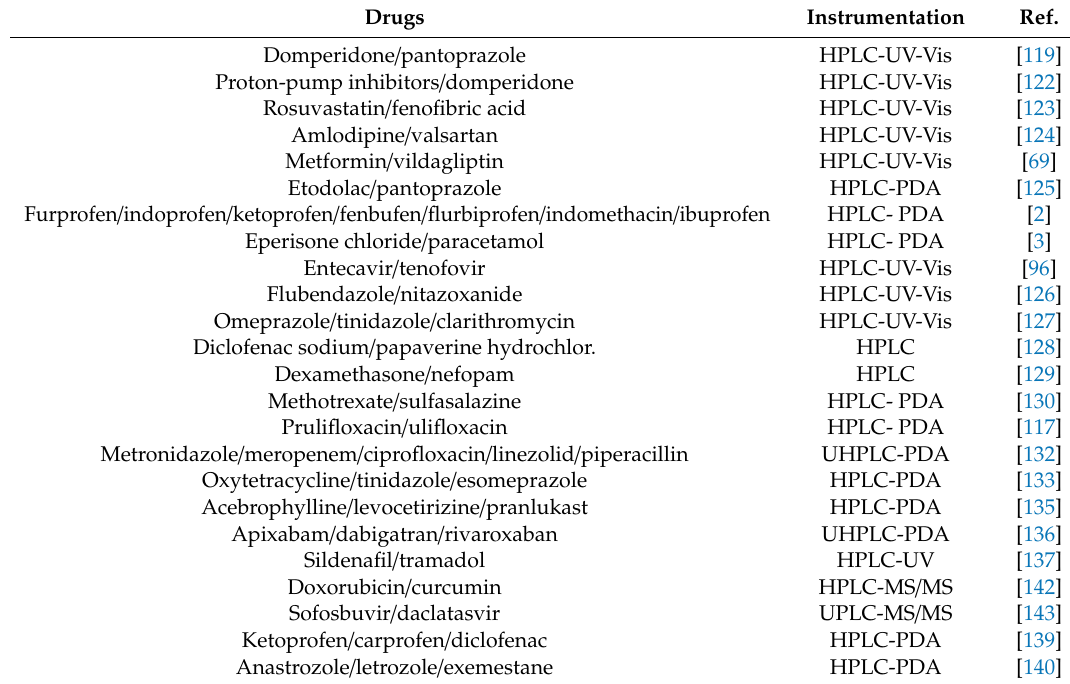
Table 6. Analytical procedures developed and validated for drug-association analyses in plasma.